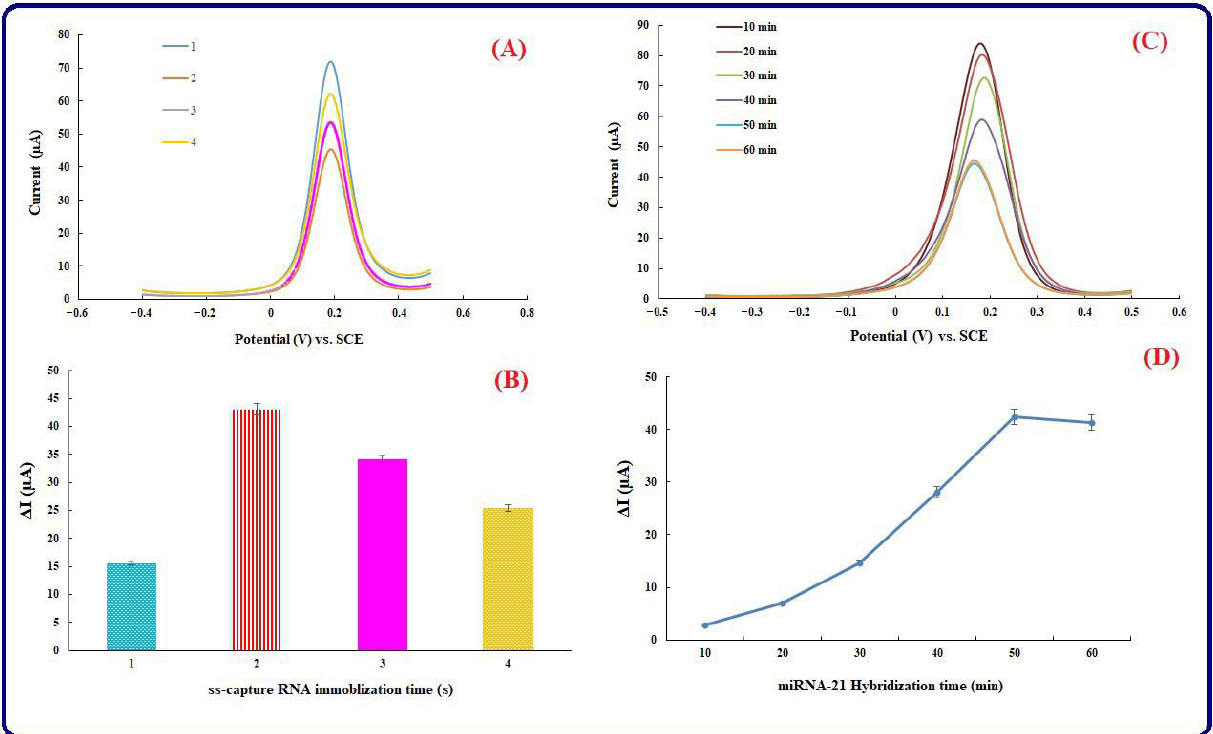
Figure 4. ( A ) DPV curves of ss-capture RNA immobilization time (10–120 min at 30-min intervals) on the surface of the gold electrode, ( B ) Histogram for ss-capture RNA immobilization time, ( C ) DPV voltammograms of the fabricated genosensor after incubation with miRNA-21 in different times (10 – 60 min at 10-min intervals). [Fe(CN) 6 ] 3−/4− is applied as a redox probe, ss-capture RNA concentration is 1 µM, and also the scan rate is 50 mV s −1 , ( D ) Histogram of miRNA-21 incubation time. Equilibration time = 0, E initial = −0.2 V, E end = 0.5 V, Estep = 0.1 V, frequency = 10 Hz, and amplitude = 0.01995 V.